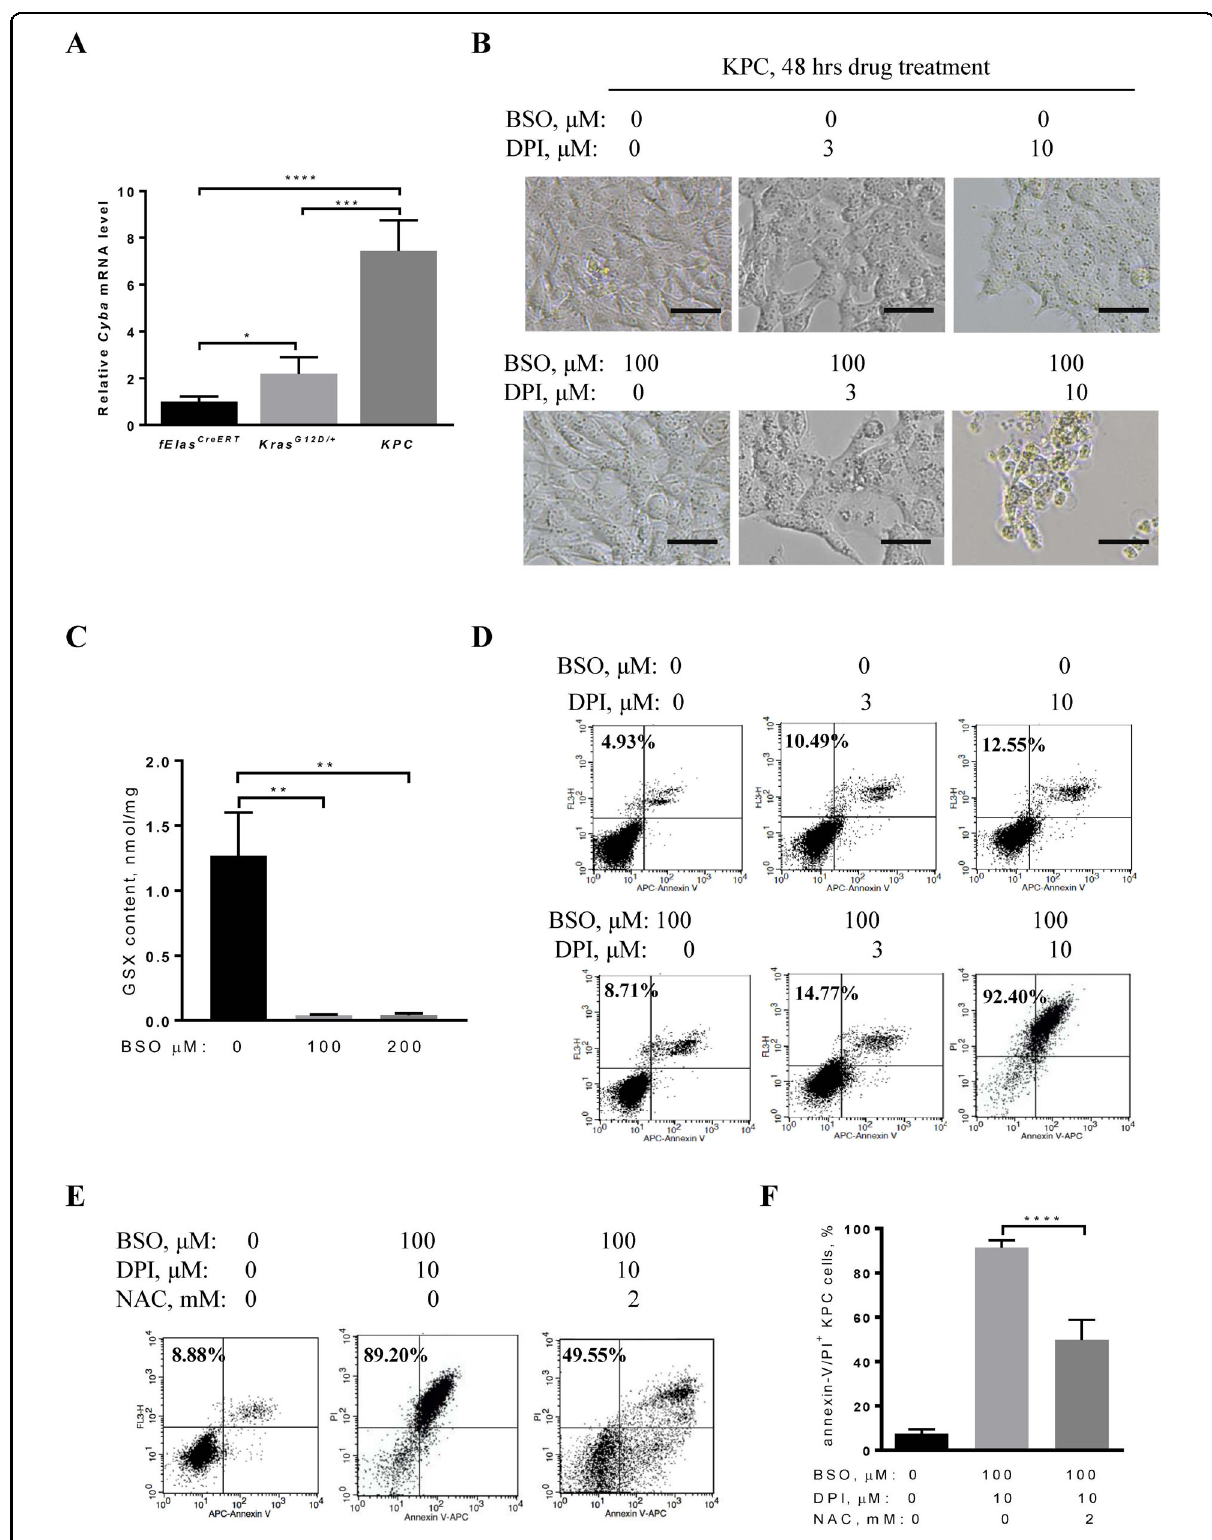
Fig. 5 (See legend on next